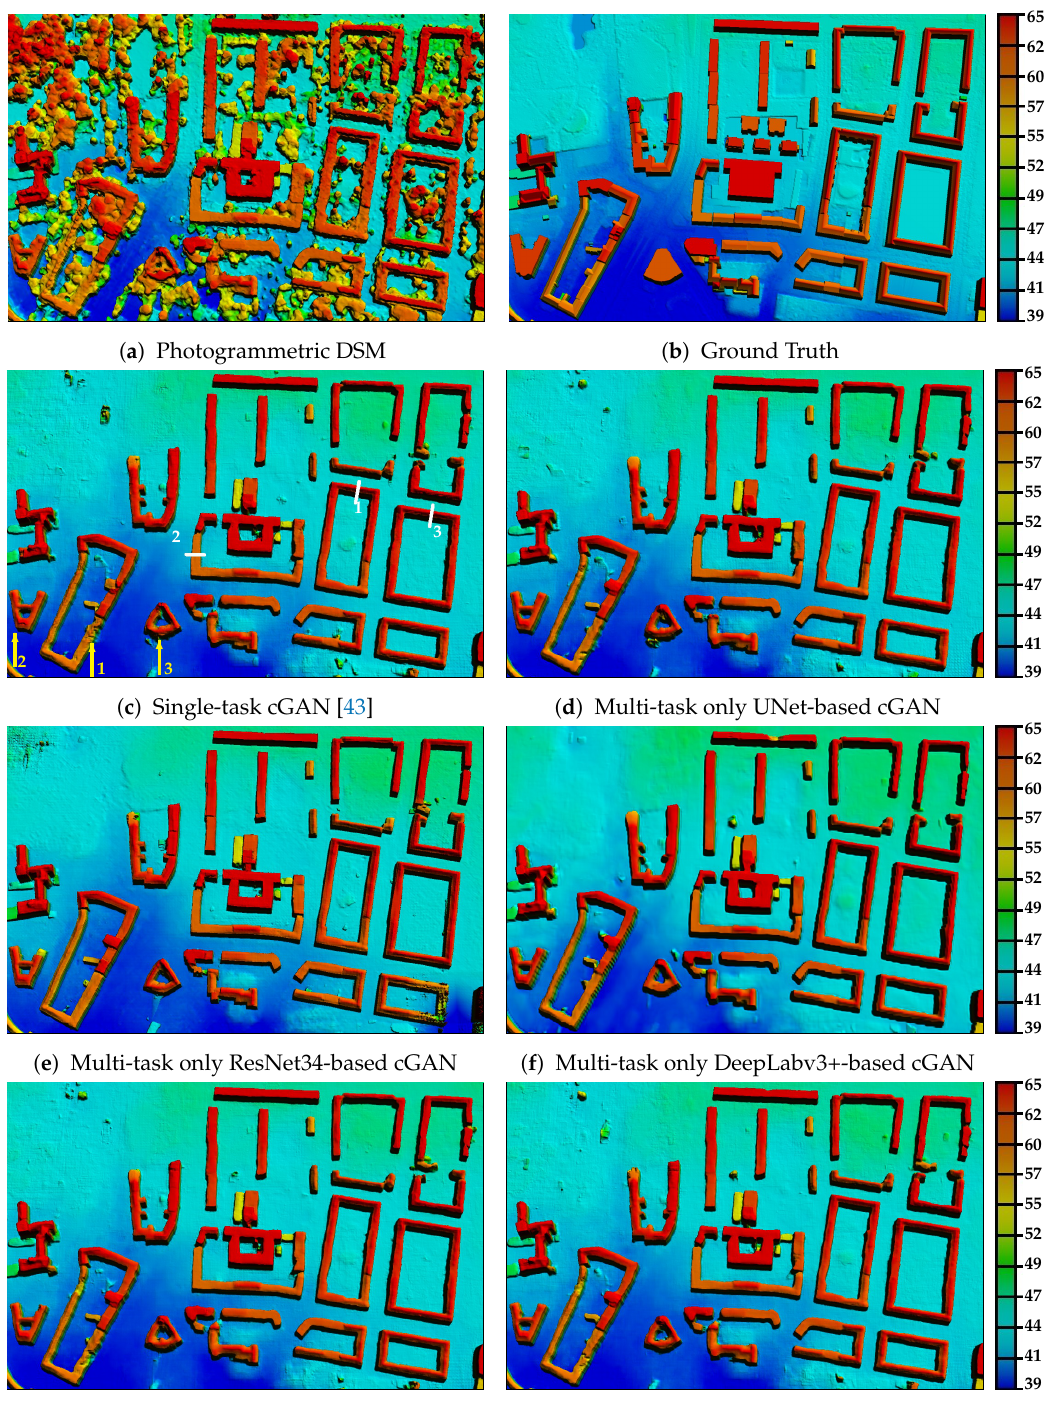
Figure 3. Visual comparison of DSMs over selected urban areas, generated by a cGAN with least squares residuals using ( c ) the one-stream generator network for a single task [43], ( d ) the one-stream generator based on the UNet network for multiple tasks, ( e ) the one-stream generator based on ResNet34 network for multiple tasks, ( f ) the one-stream generator based on the DeepLabv3+ network for multiple tasks, ( g ) the two-stream generator network with jointly trained UNet and ResNet34 architectures for multiple tasks, and ( h ) the two-stream generator network with jointly trained UNet and DeepLab architectures for multiple tasks. The DSMs images are color-shaded for better